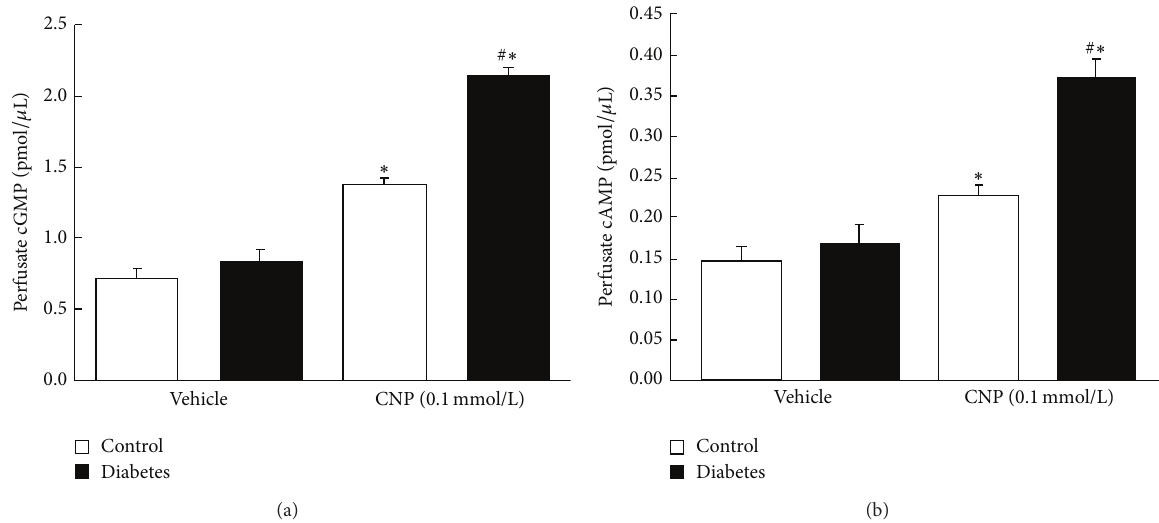
Figure 2: Effect of CNP on intracellular cGMP and cAMP levels in gastric smooth muscle of diabetic and control rats. (a) CNP increased intracellular cGMP level in gastric smooth muscle, which was more significant in the diabetic rats than in controls ( 𝑛 = 8 , # 𝑃 < 0.01 versus vehicle, ∗ 𝑃 < 0.01 versus control). (b) CNP increased intracellular cAMP level in gastric smooth muscle, which was more significant in the diabetic rats than in controls ( 𝑛 = 8 , # 𝑃 < 0.01 versus vehicle, ∗ 𝑃 < 0.01 versus